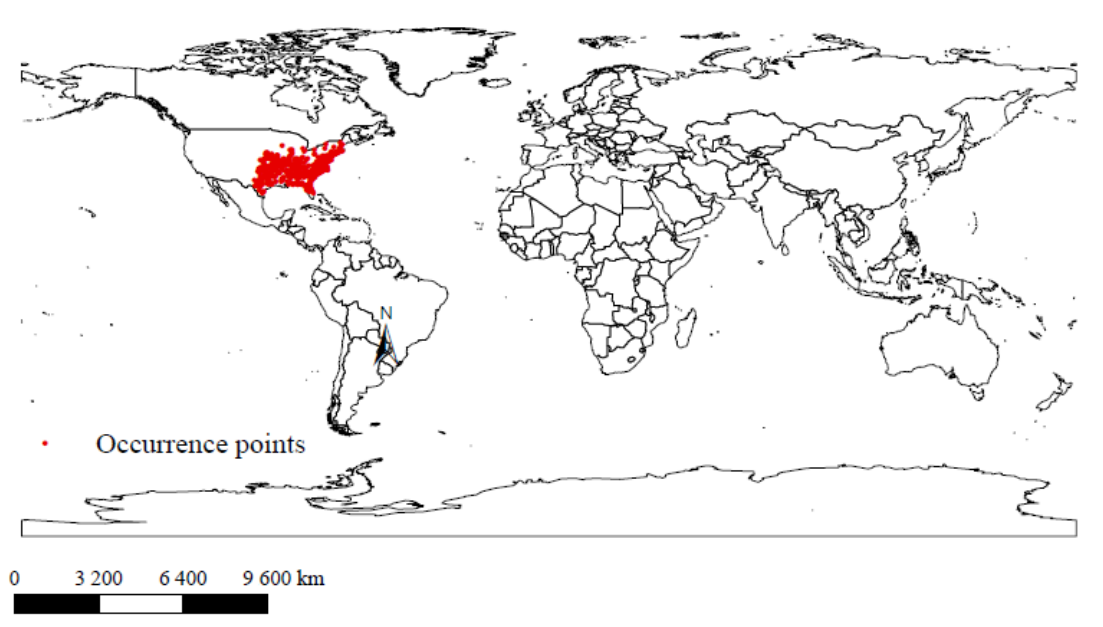
Figure 2. Current occurrence and global distribution of A. americanum.